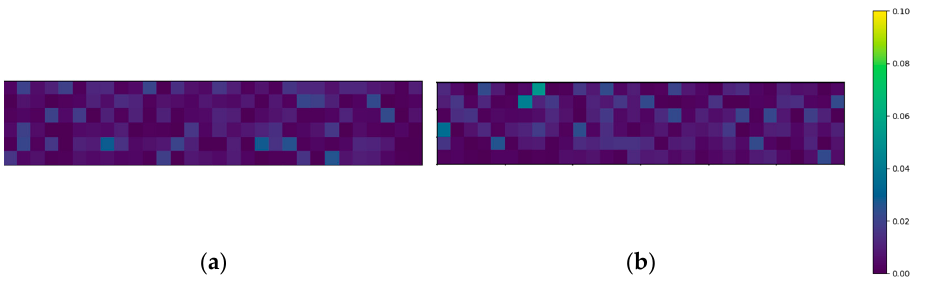
Figure 4. Flaw depth distribution for ( a ) top and ( b ) bottom surfaces (with a flaw density of 1 flaw/cm 2 for visualization).